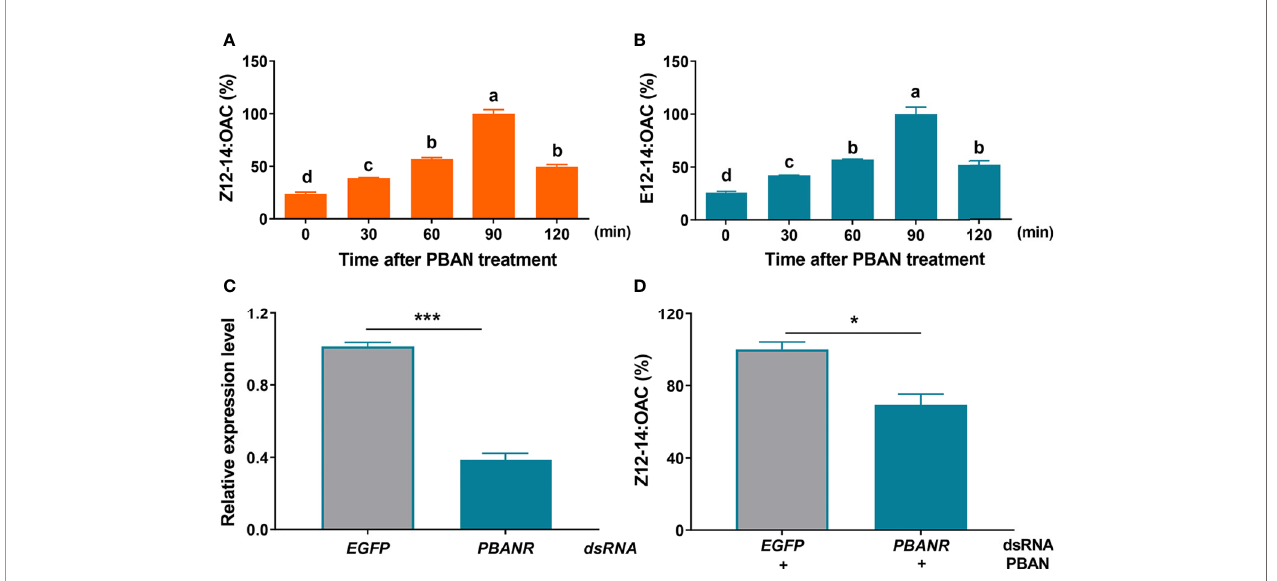
FIGURE 1 | PBAN signal mediates sex pheromone production in O. furnacalis . (A, B) The titer of sex pheromone in PGs after PBAN incubation. Data represent the mean ± SE (n = 3). A multiple comparison test with P < 0.05 was conducted to test the signi fi cant differences in different development time points (based on Tukey ’ s test, DPS7.05). (C) RNAi ef fi ciency of PBANR. (D) The effect of ds PBANR knockdown on sex pheromone production. Data represent the mean ± SE (n = 3). Statistically signi fi cant difference was denoted with * ( P < 0.05) and *** ( P < 0.001) as determined by Student ’ s t -test. Small letters a-d indicate signi fi cant